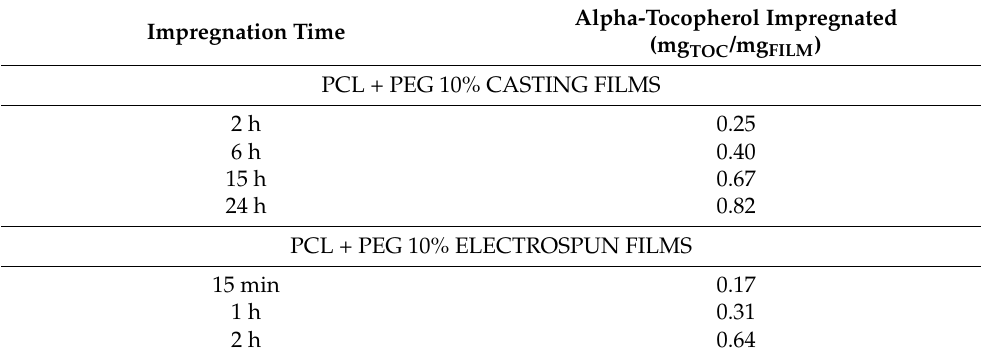
Figure 6. FESEM images of the casted samples at different PEG percentages after an impregnation time of 24 h, at 35 ◦ C and 170 bar. Table 4. Alpha-tocopherol loading on PCL + 10% PEG films produced by casting and electrospinning technique at different impregnation times, at 35 ◦ C and 170